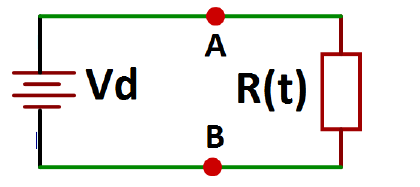
Figure 3. Nonlinear load R ( t ) incorporated into the